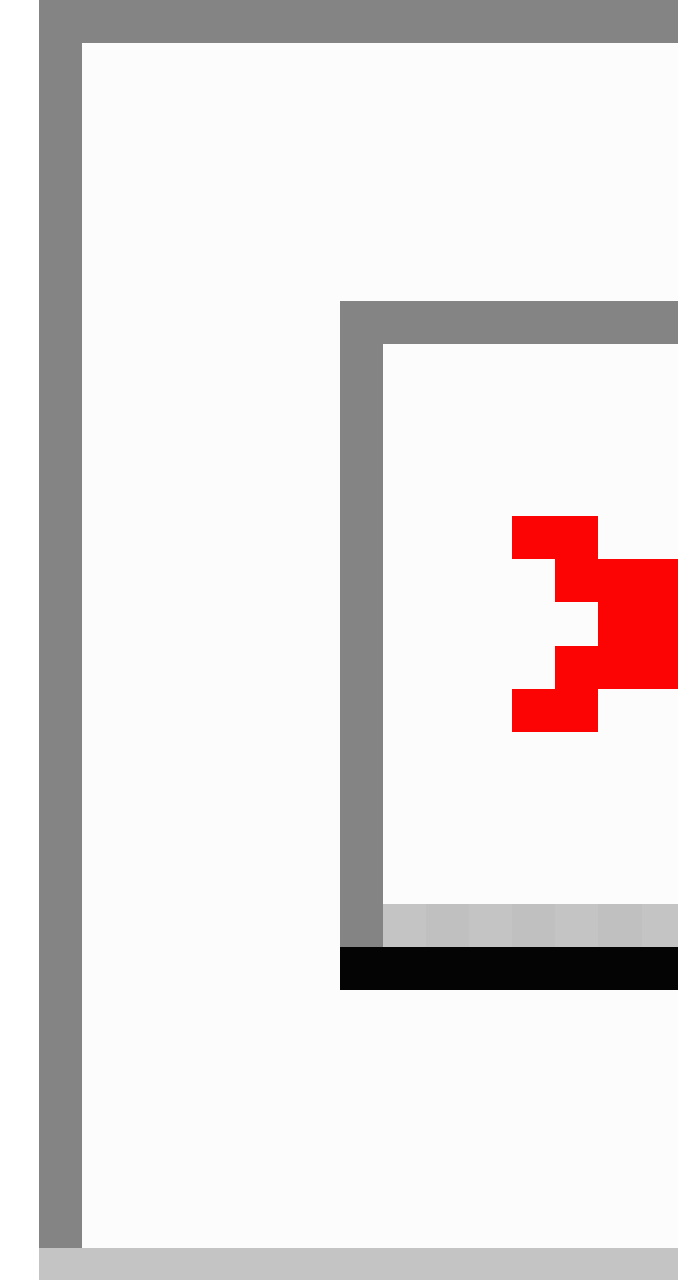
Figure 2. Numbers of participants giving discrepant or inconsistent